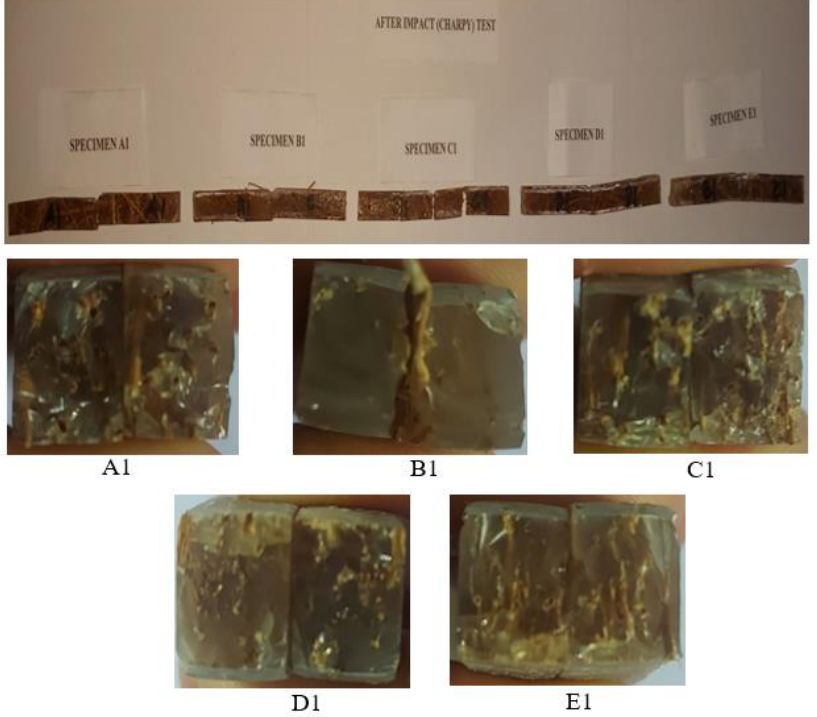
Figure 10. Variation in impact specimen failure and sample cross-sectional images for NaOH ( A 1 ) 4%; ( B 1 ) 4.5%; ( C 1 ) 5%; ( D 1 ) 5.5%; ( E 1 )